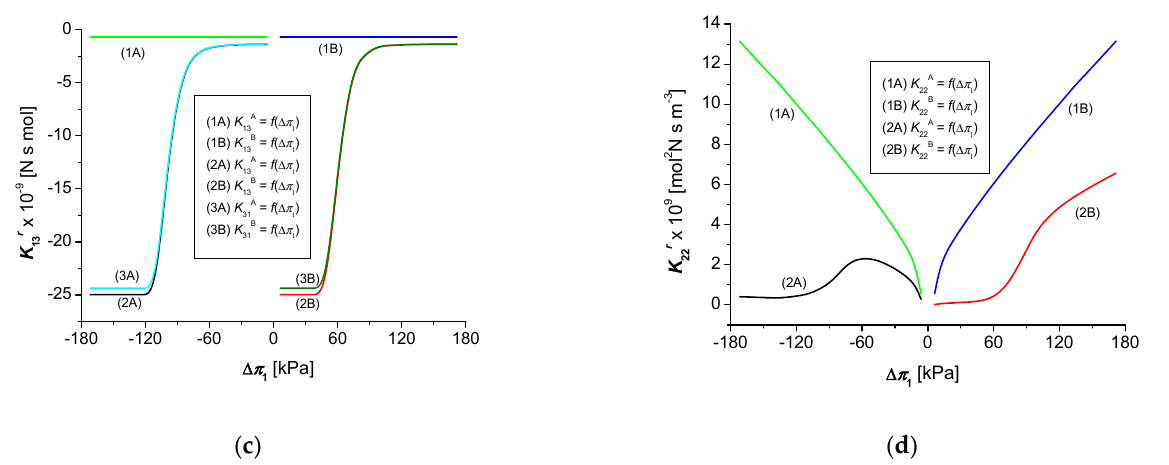
Figure 5. Coefficients 𝐾 (cid:3036)(cid:3037)(cid:3045) ( i , j ∈ {1, 2, 3}, r = A, B) as functions of glucose osmotic pressure difference ( ∆𝜋 (cid:2869) ) and ∆𝜋 (cid:2870) = 490.2 kPa: 𝐾 (cid:2869)(cid:2869)(cid:3045) ( a ), 𝐾 (cid:2869)(cid:2870)(cid:3045) and 𝐾 (cid:2870)(cid:2869)(cid:3045) ( b ), 𝐾 (cid:2869)(cid:2871)(cid:3045) ( c ), 𝐾 (cid:2870)(cid:2870)(cid:3045) ( d ).